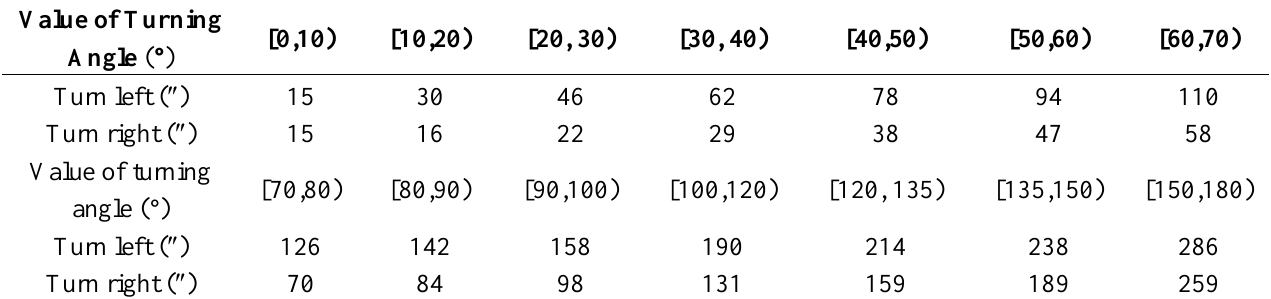
Table 2. Time-consuming model by steering based on the corners at road